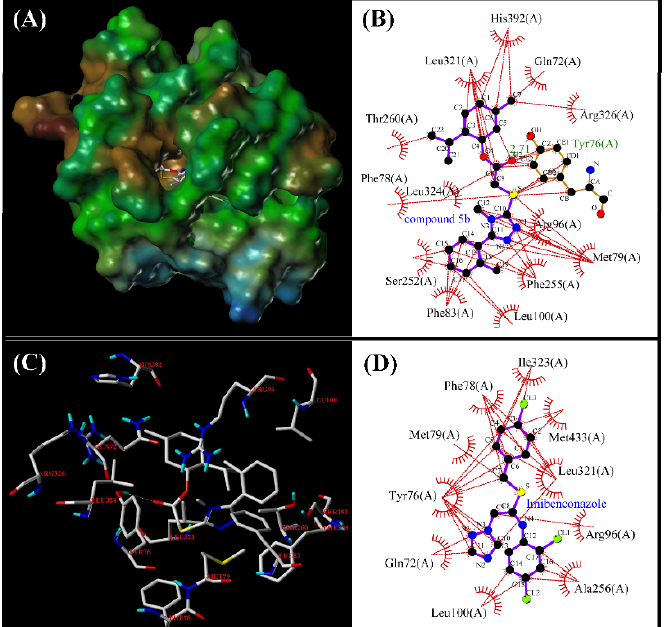
Figure 3. The binding pocket (A) and modes of compound 5b (R = o -CH3 Ph) respectively presented in the 2D (B) and 3D pattern (C) , along with the binding modes of imibenconazole presented in the 2D pattern (D) .